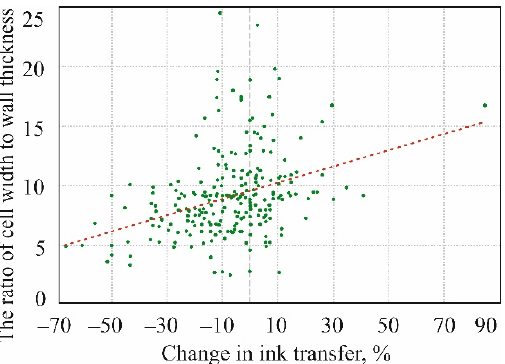
Figure 11. Dependency of the change in the amount of ink transferred by the anilox rollers on the ratio of cell width to wall thickness (rollers with 60° engraving only).